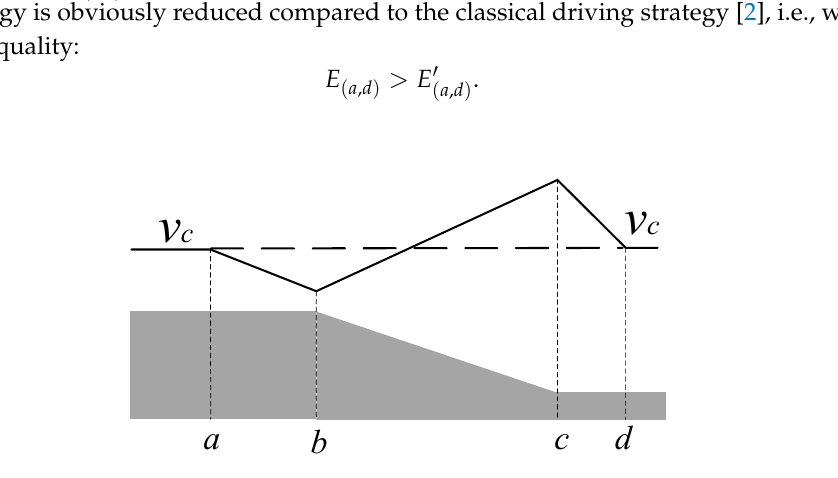
Figure 7. Local optimization at the steep downhill segment.